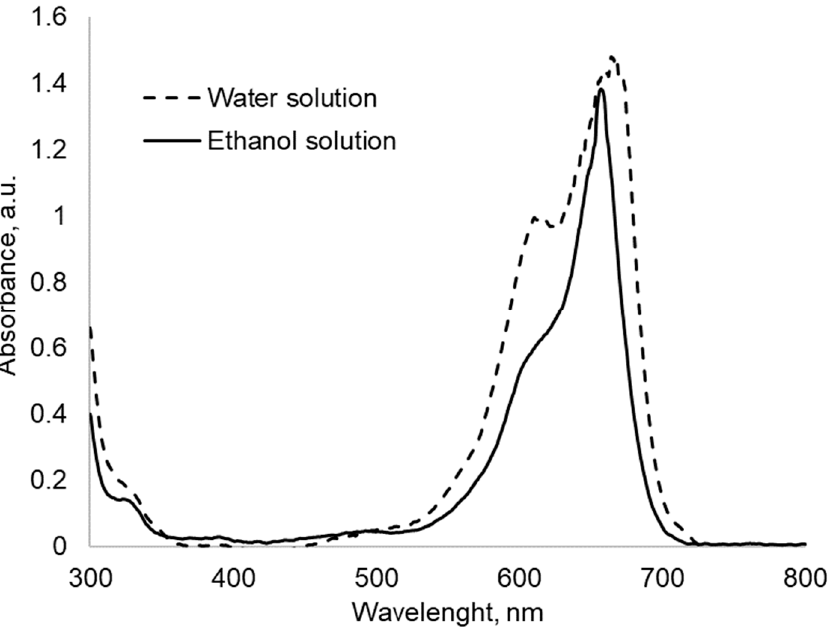
Figure 3. Absorption spectra of 0.01 g / L of methylene blue solution.